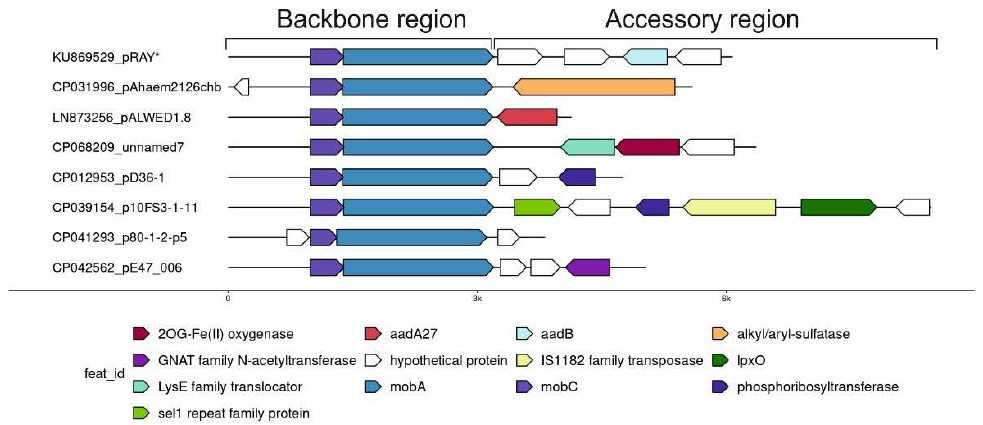
Figure 2. Plasmid pRAY* and related small